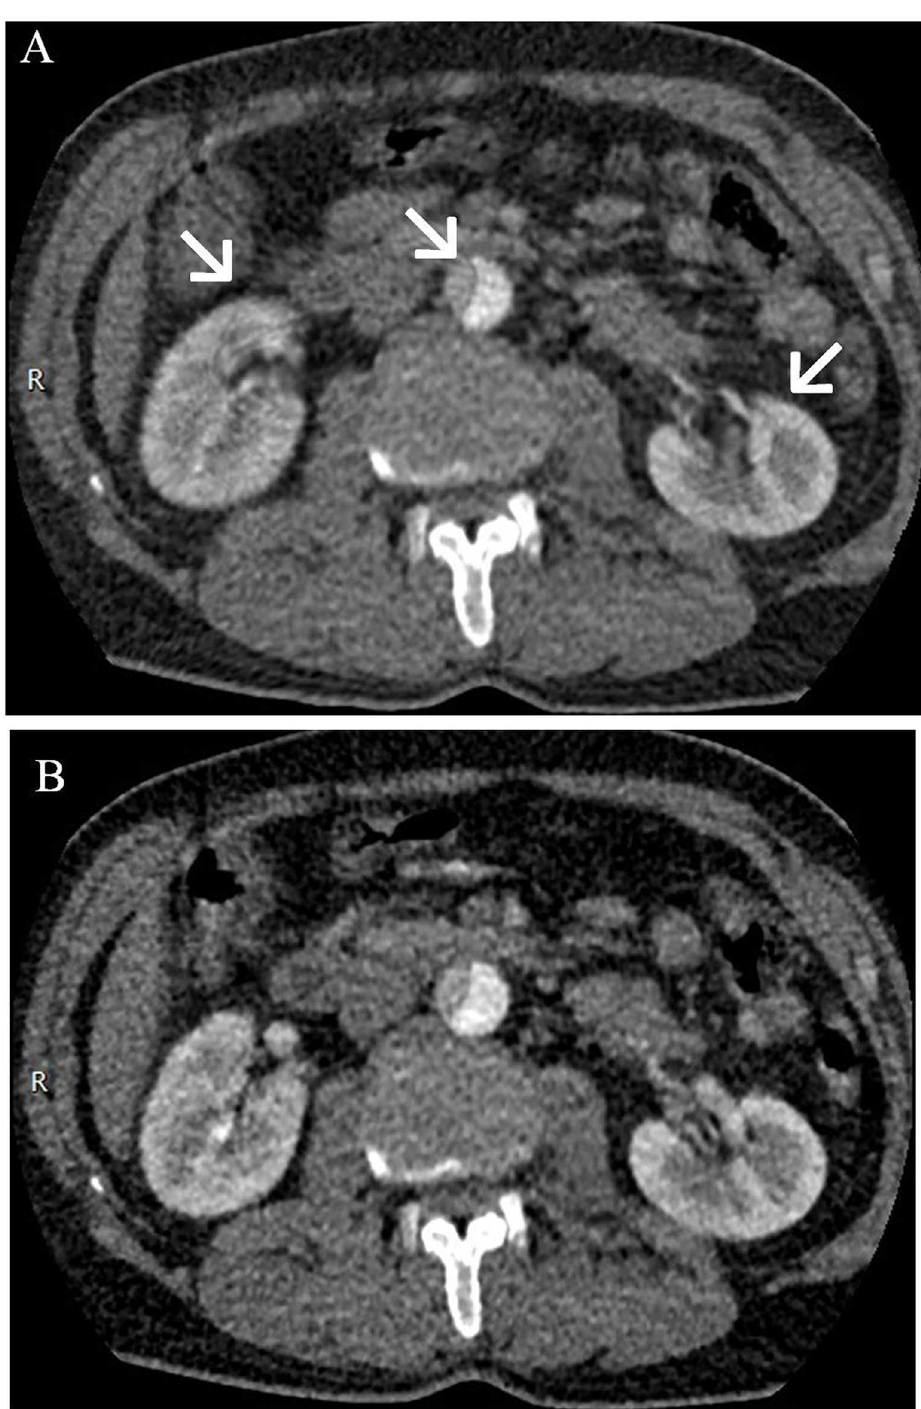
Fig 1. Transverse contrast-enhanced CT scan showed the effect of motion correction. (A) Motion artifacts were seen as blurringof the kidney and aorta contours (white arrowheads). (B) Most motion artifacts were not seen after